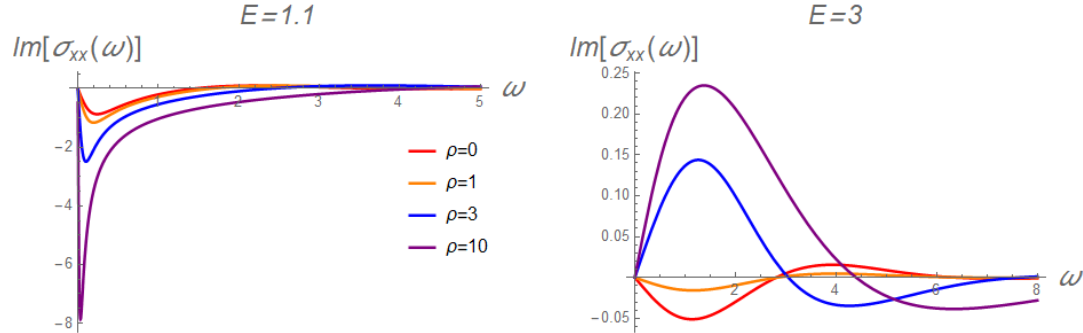
Figure 4 . Imaginary part of the longitudinal (cid:27) xx conductivity for di(cid:11)erent values of electric (cid:12)eld E and charge density (cid:26)